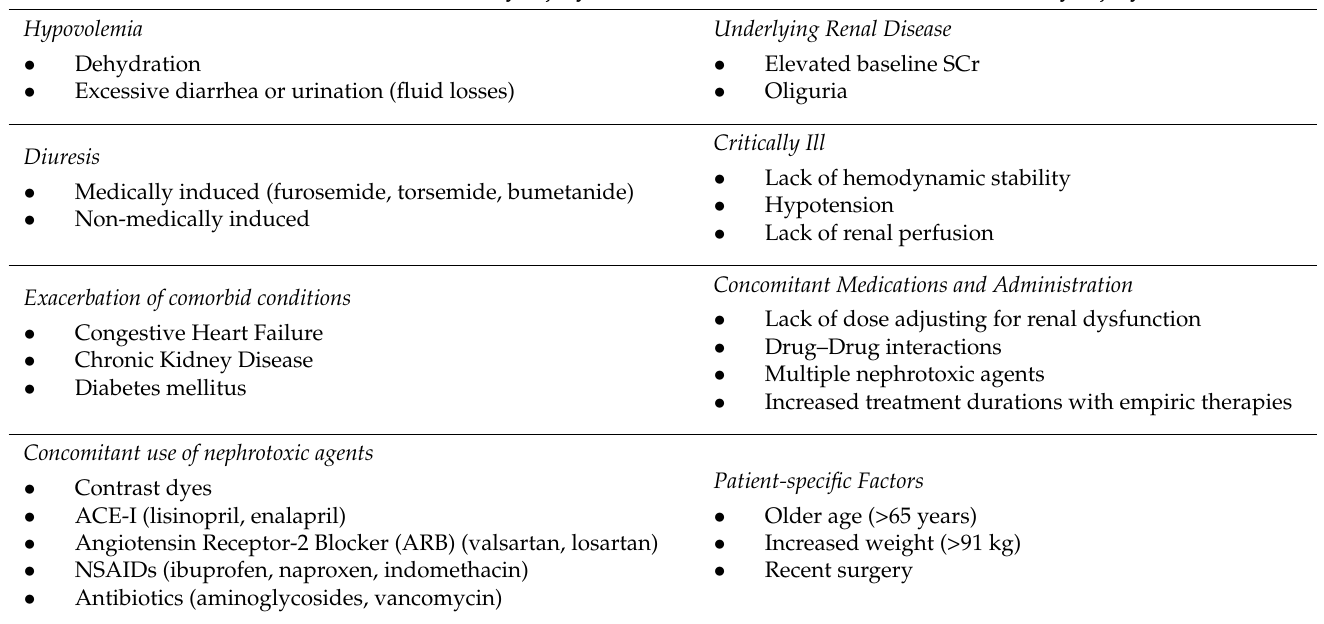
Table 2. Common risk factors for acute kidney injury (AKI) and antibiotic-associated acute kidney injury